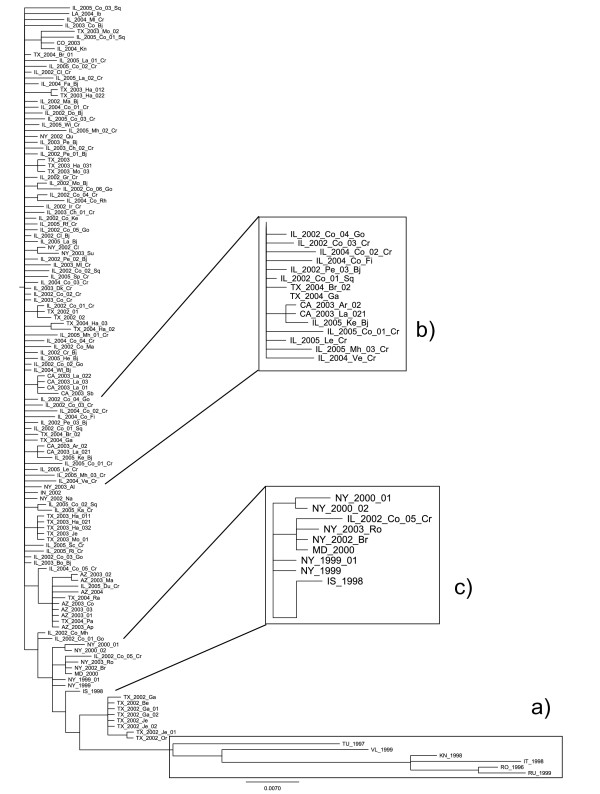
(λ + μ)-EA best tree. The new graphic representation of the best result among final trees obtained by the (λ + μ)-EA, (1 + 5) in particular. Biologically meaningful improvements in the vertical order of taxa can be seen, involving samples collected in the same year or state (magnified in b), or the clade containing European strains was moved to the bottom of the tree (a), and the relationship between the NY99 and Israel98 samples is highlighted (c).